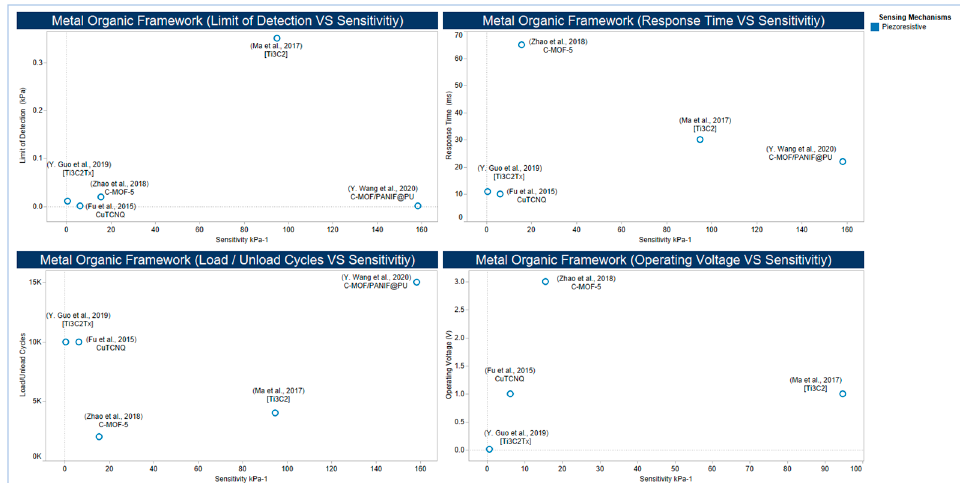
Figure 17. Performance of some MOF- and MXene-based sensors.